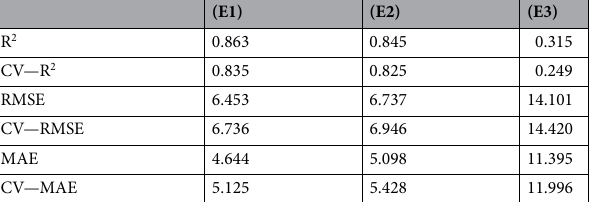
Table 2. Leave-one-out cross validation results for all the models. It is possible to see a general decrease in all the diagnostic indicators considered to evaluate the regression formulas (CV: cross-validated; RMSE: root mean square error; MAE: mean absolute